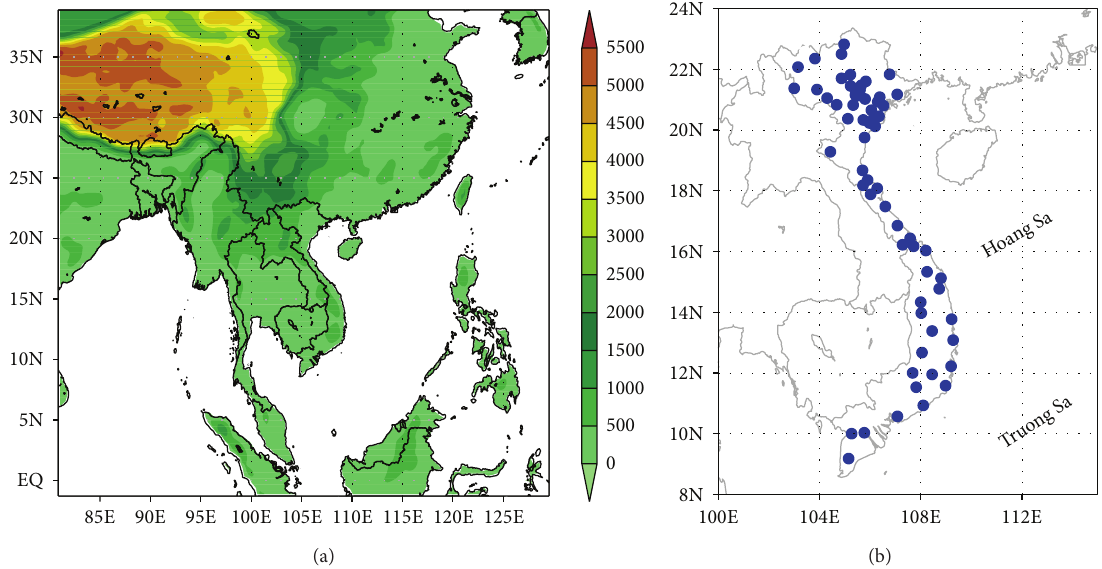
Figure 1: (a) The employed RegCM4.2 domain with model topography (m a.s.l.) and (b) locations of 64 meteorological stations used in this study.